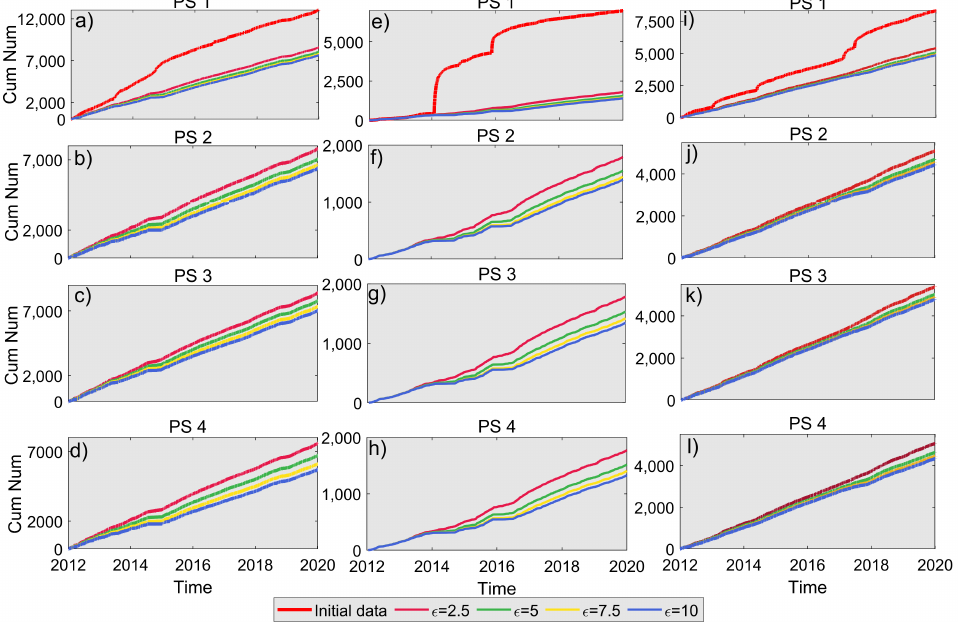
Figure A4. Cumulative number of the initial datasets (red line) and cumulative number of back- ground seismicity for each parameter set (PS1-PS4) and for four different distance thresholds ( (cid:101) = 2.5, 5, 7.5, 10 km). ( a – d ) Dataset D1, ( e – h ) dataset D2 and ( i – l ) dataset